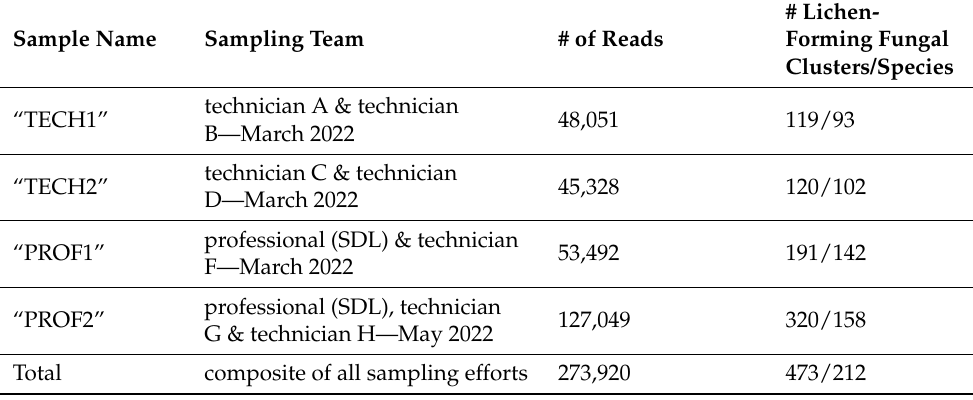
Table 1. Summary of the four distinct sampling efforts, including the sample name, a description of the participants within each team, and number of reads resulting from the amplicon sequencing using Illumina’s MiSeq, and the number of lichen-forming clusters and candidate species represented by ≥ 5